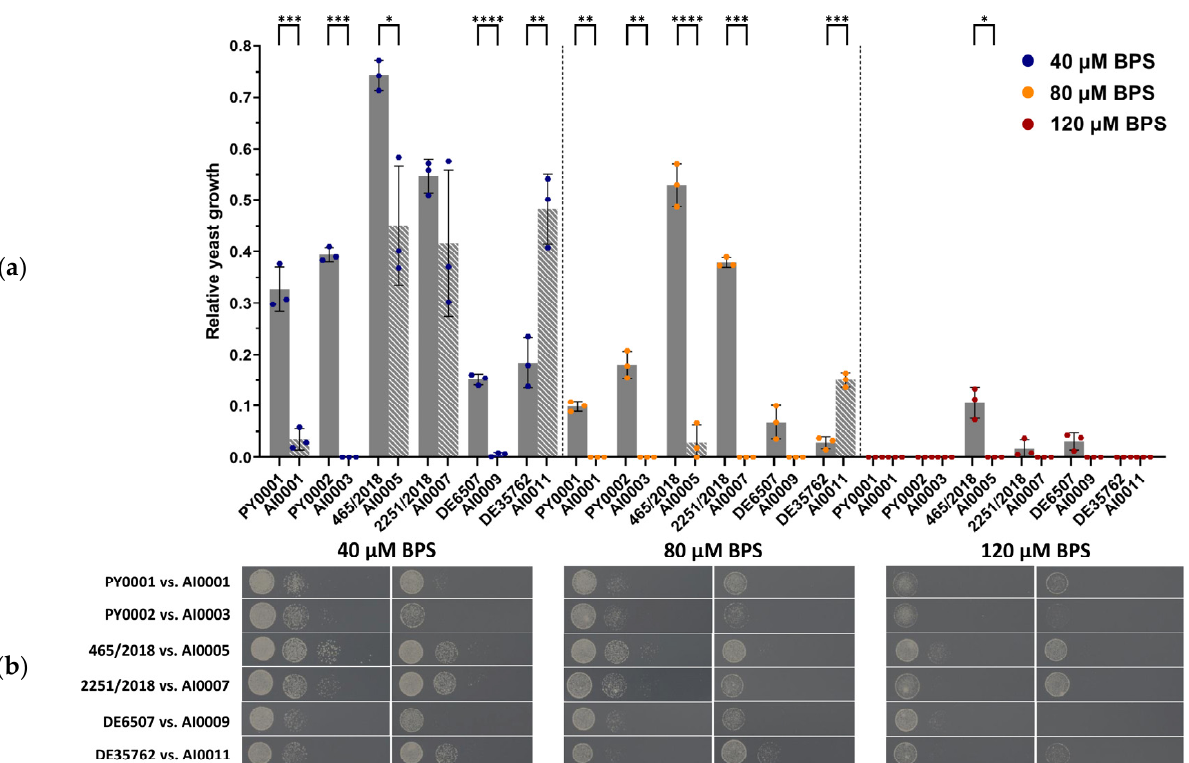
Figure 3. Relative yeast growth under iron starvation: ( a ) bars show the mean results for the wild type S. ‘boulardii’ isolate triplicates (full grey bars) and for the ∆∆ HMX1 mutant strain triplicates (striped bars) (for the second spot with 5000 plated cells). Individual data points are shown in blue (40 µ M BPS), orange (80 µ M BPS), and red (120 µ M BPS), and whiskers show the standard deviation of the data. Comparisons with significant differences are marked (*: p < 0.05; **: p < 0.01; ***: p < 0.001; ****: p < 0.0001). ( b ) Photos of iron deprivation spot plate assay. Columns represent the wild type isolate vs. ∆∆ HMX1 mutant strain pairs by BPS concentration. Raw photographs, including control plates without BPS, are uploaded to FigShare.